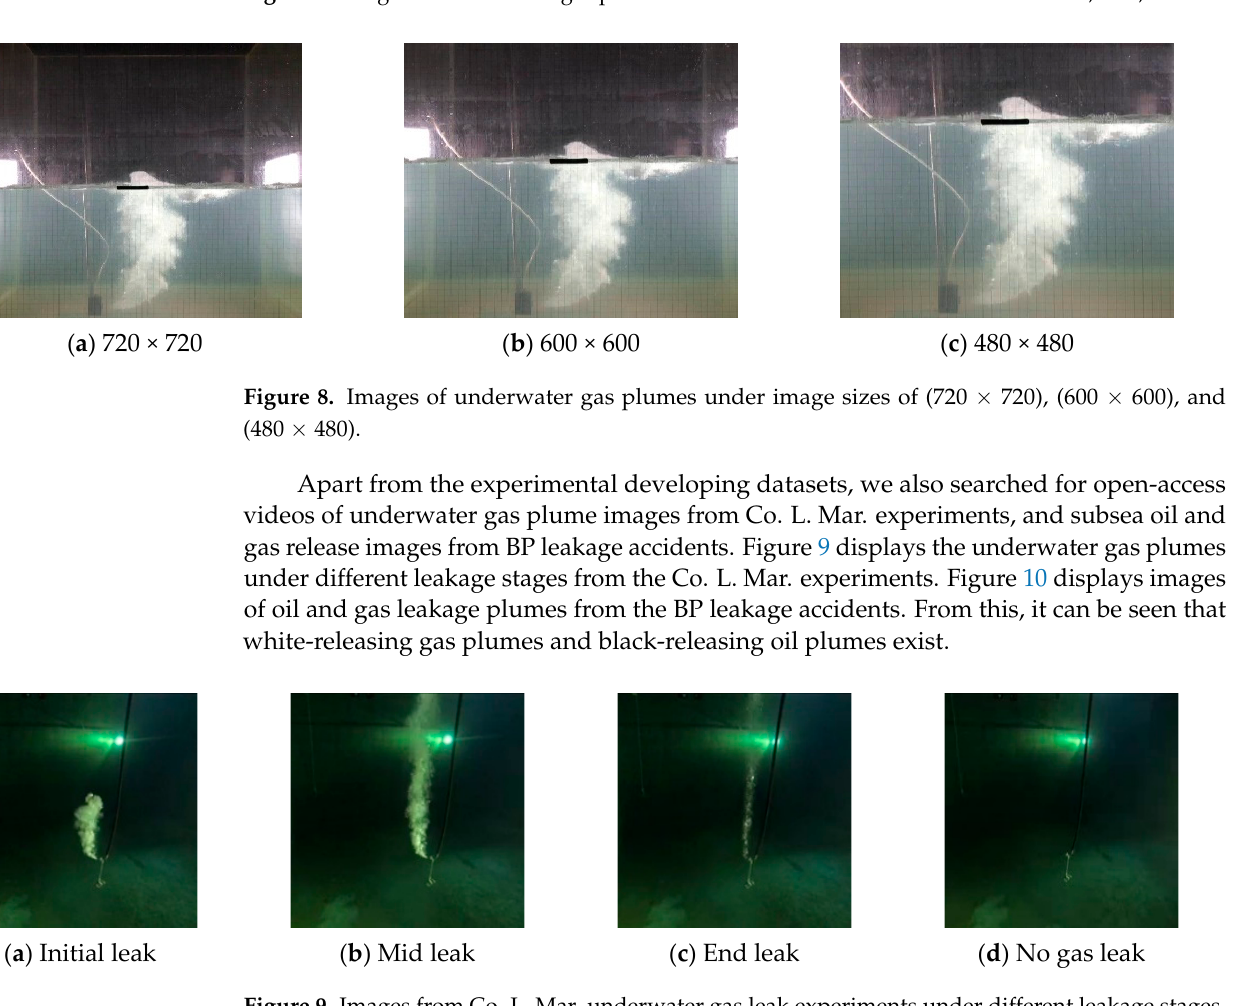
Figure 9. Images from Co. L. Mar. underwater gas leak experiments under different leakage stages.